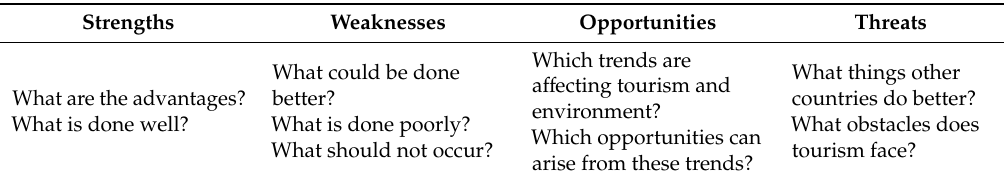
Table 4. SWOT matrix and questions put to coastal